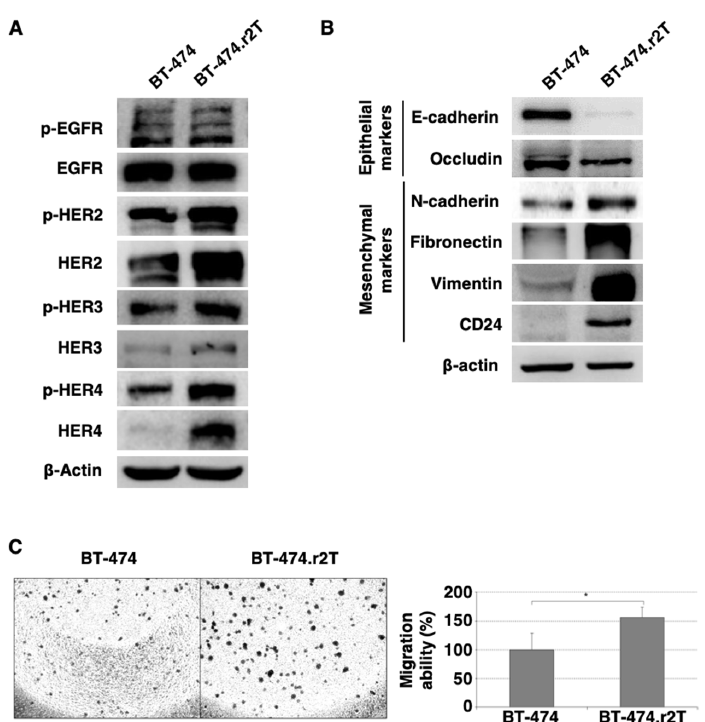
Figure 1. ( A ) The generation of trastuzumab resistance induced changes in the abundance and phosphorylation patterns of HER family members in BT-474.r2T cell line. Trastuzumab-sensitive and -resistant BT-474 cells were compared by WB for their protein levels at basal no-treatment conditions. β-actin was used as a loading control. ( B ) Changes were observed for different markers of EMT. ( C ) The acquisition of resistance to trastuzumab enhances transwell migration in resistant cells as compared to parental, sensitive BT-474 cells (* denotes p < 0.05).